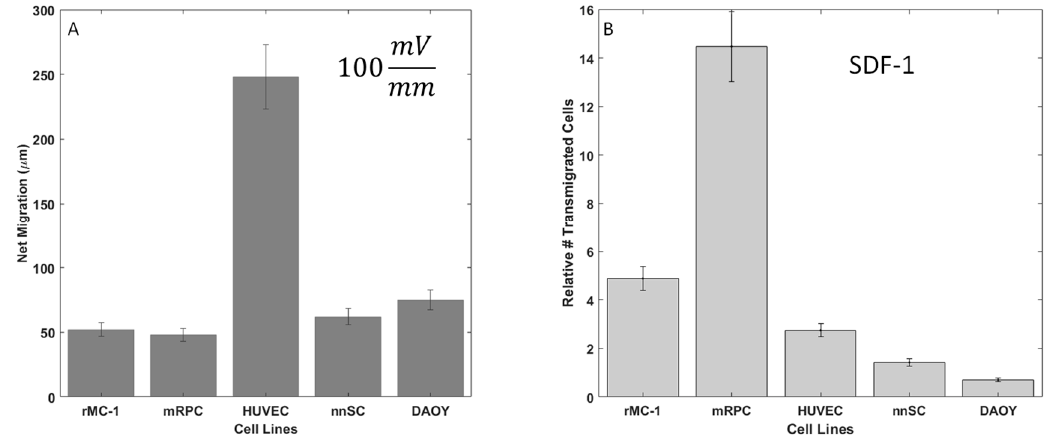
Table 2. Average Electrotaxis Migration Statistics.